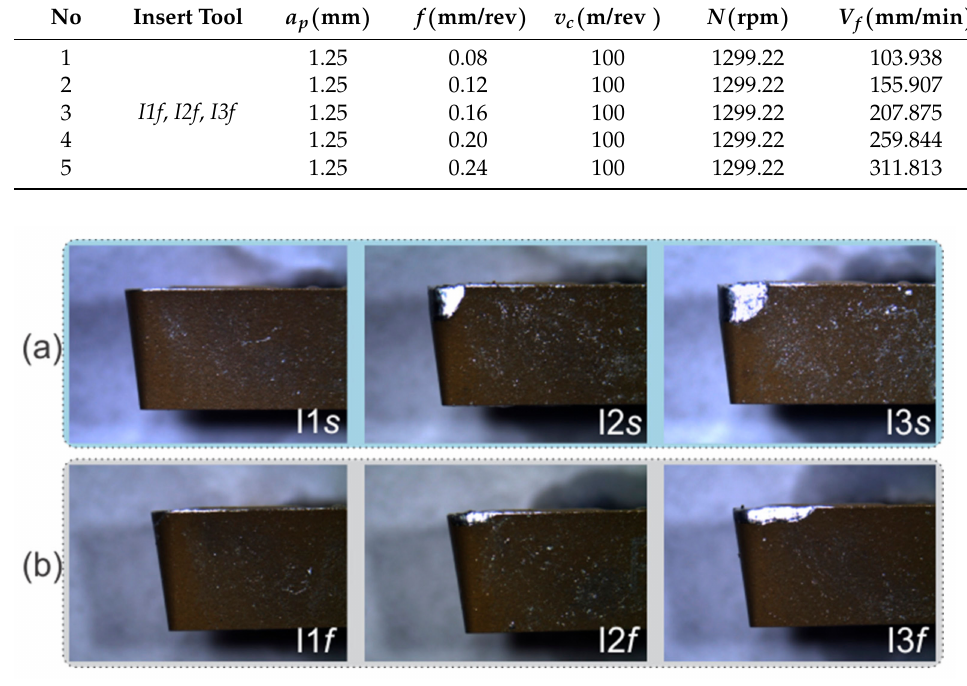
Figure 8. Inserts without wear and with medium and excessive tool wear for experimentation: ( a ) cutting speed, and ( b ) feed rate